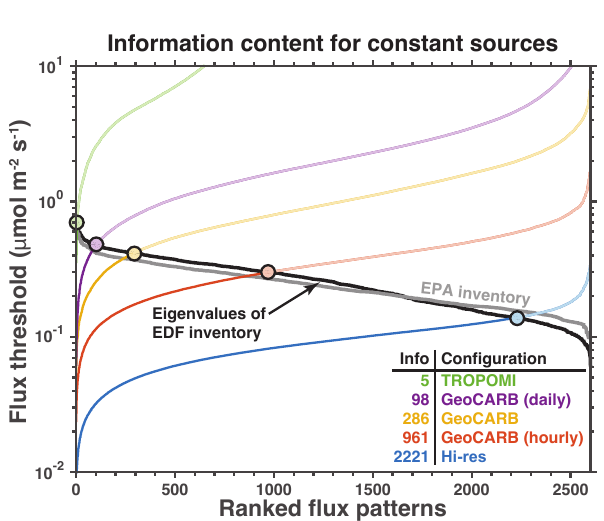
Figure 5. Capability of different configurations for satellite obser- vations of atmospheric methane (Table 1) to resolve the fine-scale (1.3 × 1.3km 2 ) patterns of variability of temporally invariant emis- sions in a 290 × 235km 2 domain and for a 1-week observation pe- riod. The colored lines show the flux thresholds for the different emission patterns of variability in the domain, as given by the or- dered inverse square roots of the eigenvalues of the Fisher informa- tion matrix. Solid black line is the eigenvalues of the emissions from the EDF Barnett Shale methane inventory (Lyon et al., 2015) and the solid gray line is the gridded EPA inventory. The region above the black line is where the noise is larger than the signal. Filled circles indicate the information content of the observing system ( I ) for a given satellite configuration at 1.3 × 1.3km 2 spatial resolution. In- set table lists the information contents for the five